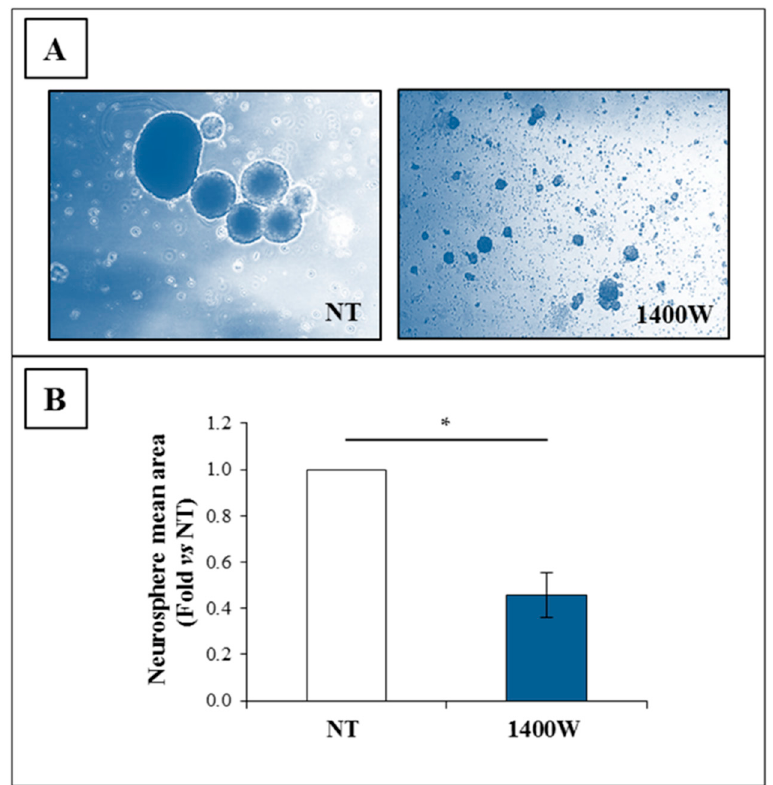
Figure 6. Nitric oxide synthase (NOS) activity inhibition strongly affects U-87 MG neurosphere generation. ( A ) Representative phase contrast images (4× magnification) of human U-87 MG cell line maintained in glioma stem cells condition (GSC-M) to allow neurospheres’ generation in the absence (not treated, NT) or presence of NOS2 activity inhibitor 1400W (100 μ M), added daily for 20 days. Baseline condition (NT) at five-day culture is shown. ( B ) Quantification analysis of neurosphere mean area expressed as fold vs. NT. Data represent mean ± SEM of two independent experiments in duplicate. For comparison between two means, Student’s unpaired t -test was used (* p < 0.05).